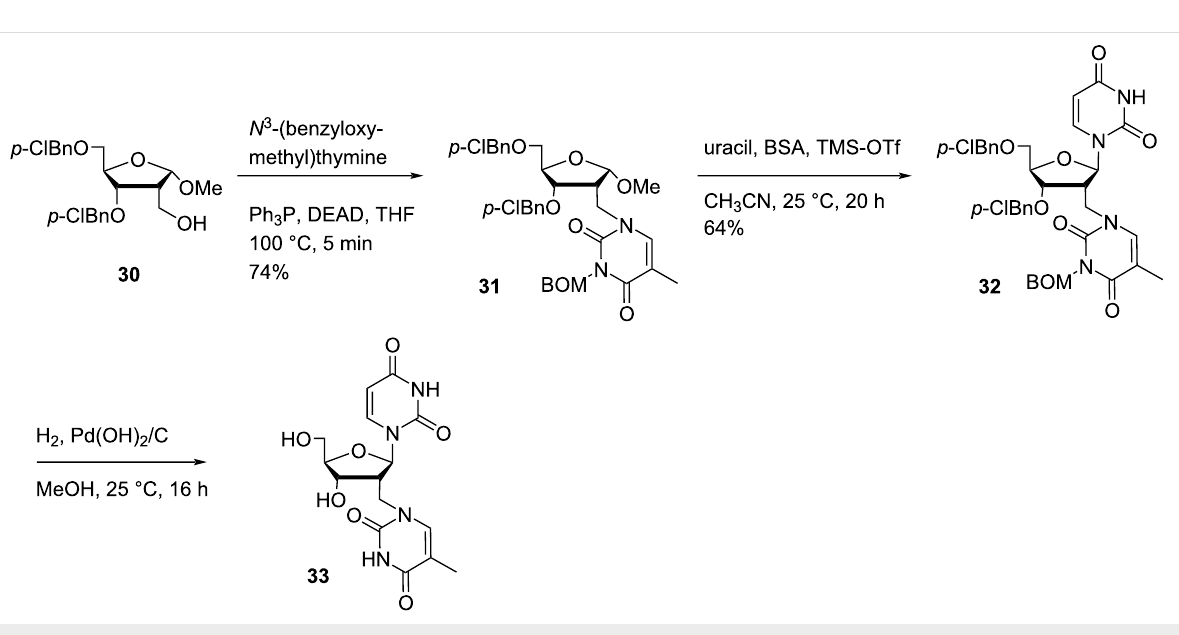
Scheme 8: Synthesis of double-headed nucleoside 33